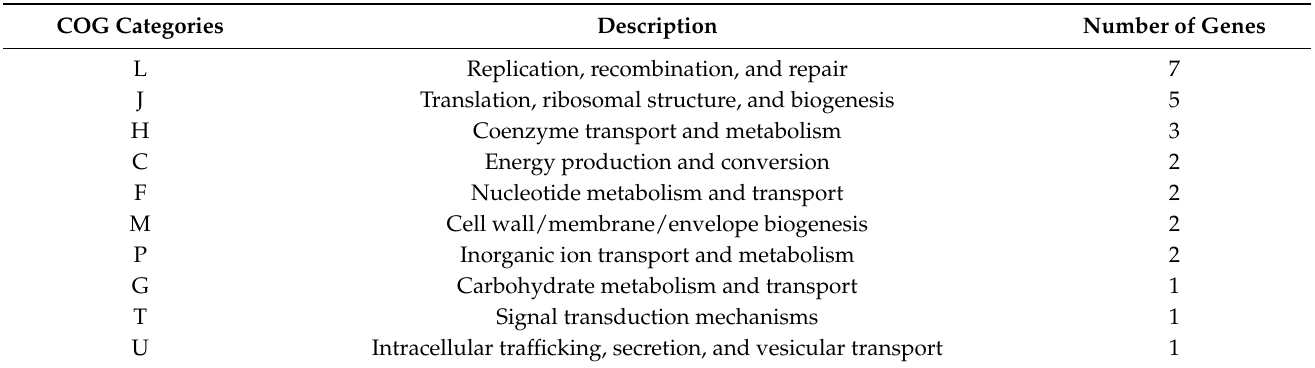
Table 4. Clusters of Orthologous Groups assigned to the protein-coding genes found in NL07 and missing in the published Ca. N. mikurensis